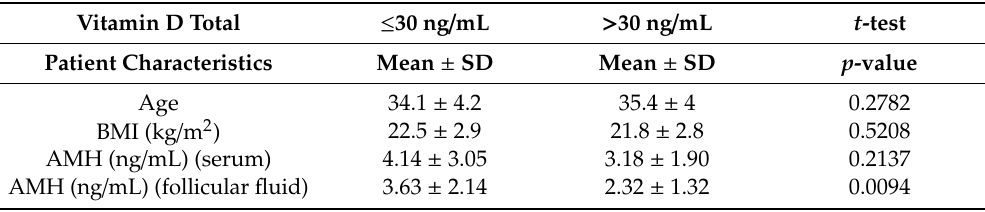
Table 2. Baseline descriptive statistics of the patients.